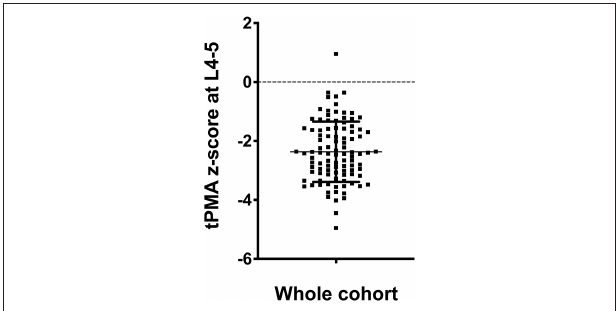
FIGURE 1 | Distribution of tPMA at L4-5. The mean tPMA z-score was − 2.37 with a standard deviation of 1.02.